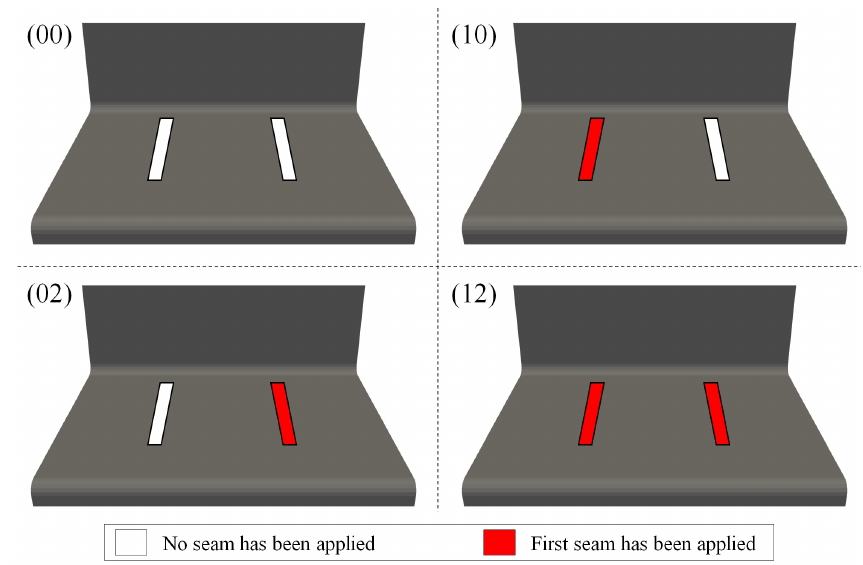
Figure 9. Cases with at least one layer was printed (red) or no layer printed (white).